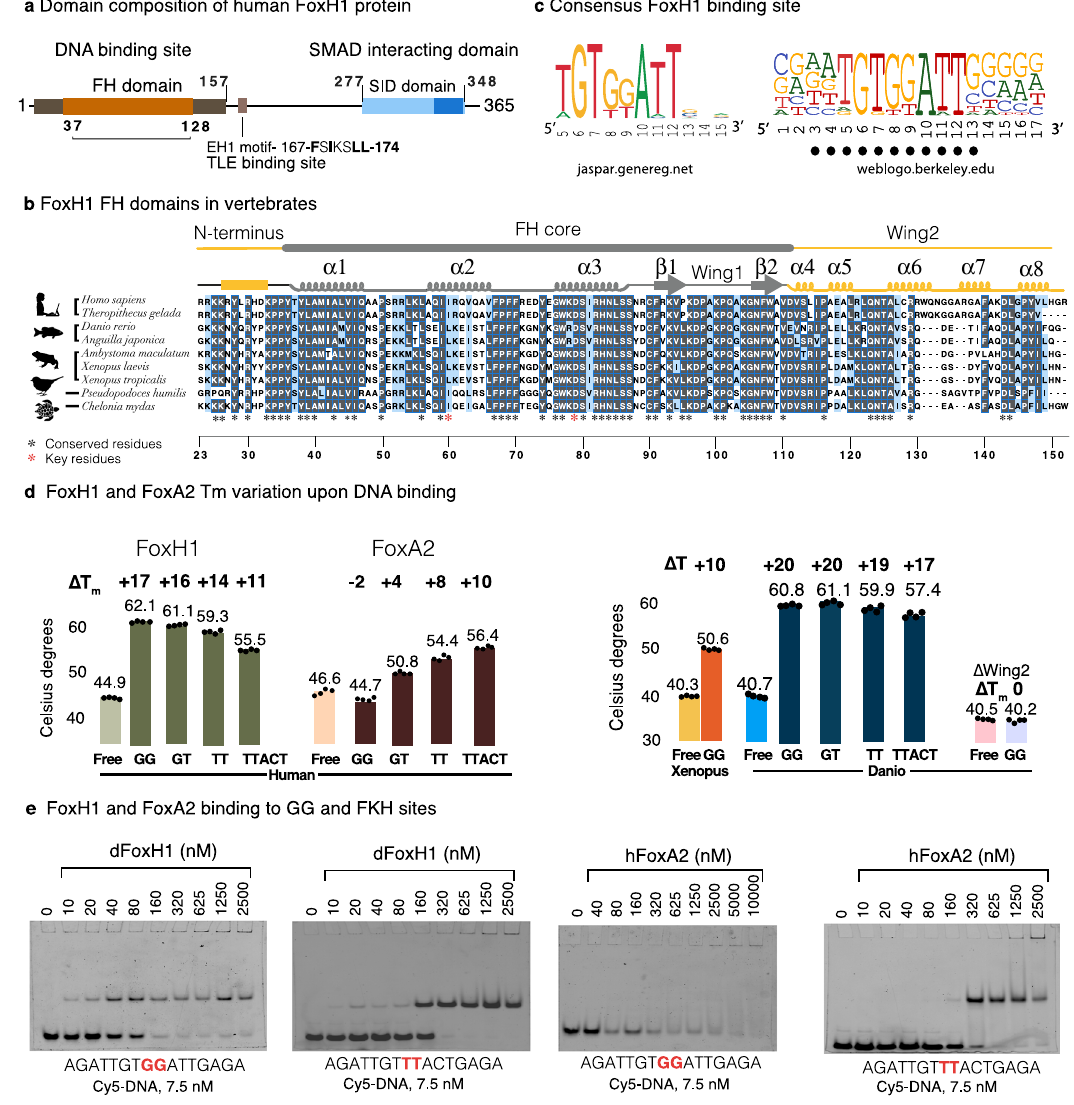
Fig. 1 | The FoxH1 FH domain binds DNA with high af fi nity. a Domain compo- sition of FoxH1 proteins. The FH and SID domains are conserved in vertebrates. b Sequence alignment of FoxH1 FH domain in vertebrates. Secondary structure elementsobservedinthehumancomplexaredepictedonthetopofthealignment. The FH core domain and the extended N- and C-termini are also indicated. Align- ments were generated with MAFFT 76 and the BoxShade server (https://bio.tools/ boxshade). Residue conservation is color coded: white: low similarity, blue: high similarity, grey: strictly conserved. c Consensus DNA binding. The sequences used to derive this consensus are shown in Supplementary Fig. 1b. Base pairs found to participate in speci fi c protein contacts are indicated. This consensus is almost identical to the JASPAR pro fi le https://jaspar.genereg.net/. d Melting temperature